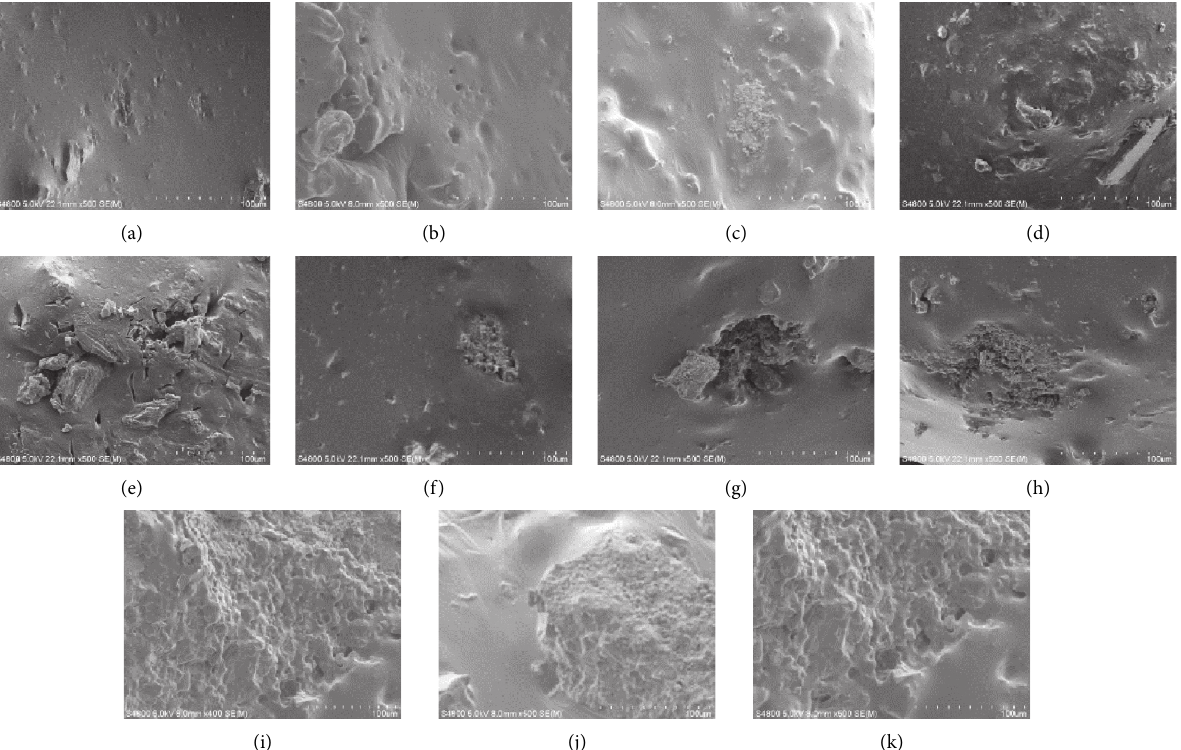
Figure 6: SEM images of PAC with a porosity of 19% after multiple freeze-thaw cycles. (a) No freezing-thawing. (b) 2 cycles. (c) 4 cycles. (d) 6 cycles. (e) 8 cycles. (f) 10 cycles. (g) 12 cycles. (h) 14 cycles. (i) 16 cycles. (j) 18 cycles. (k) 20 cycles.